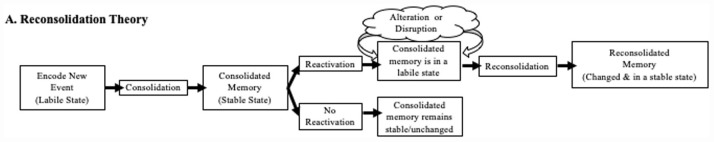
Schematic of reconsolidation theory. New events are encoded, of which the details are consolidated for long-term memory. After consolidation, an older memory can be reactivated and returned to a labile state (top pathway). Once labile, memory traces become susceptible to alteration (strengthening, weakening, or alteration). The memory must proceed through a second phase of consolidation (reconsolidation) to return to a stable memory state. If reactivation does not occur (bottom path), the memory trace remains in a stable state and is not open to direct alteration.